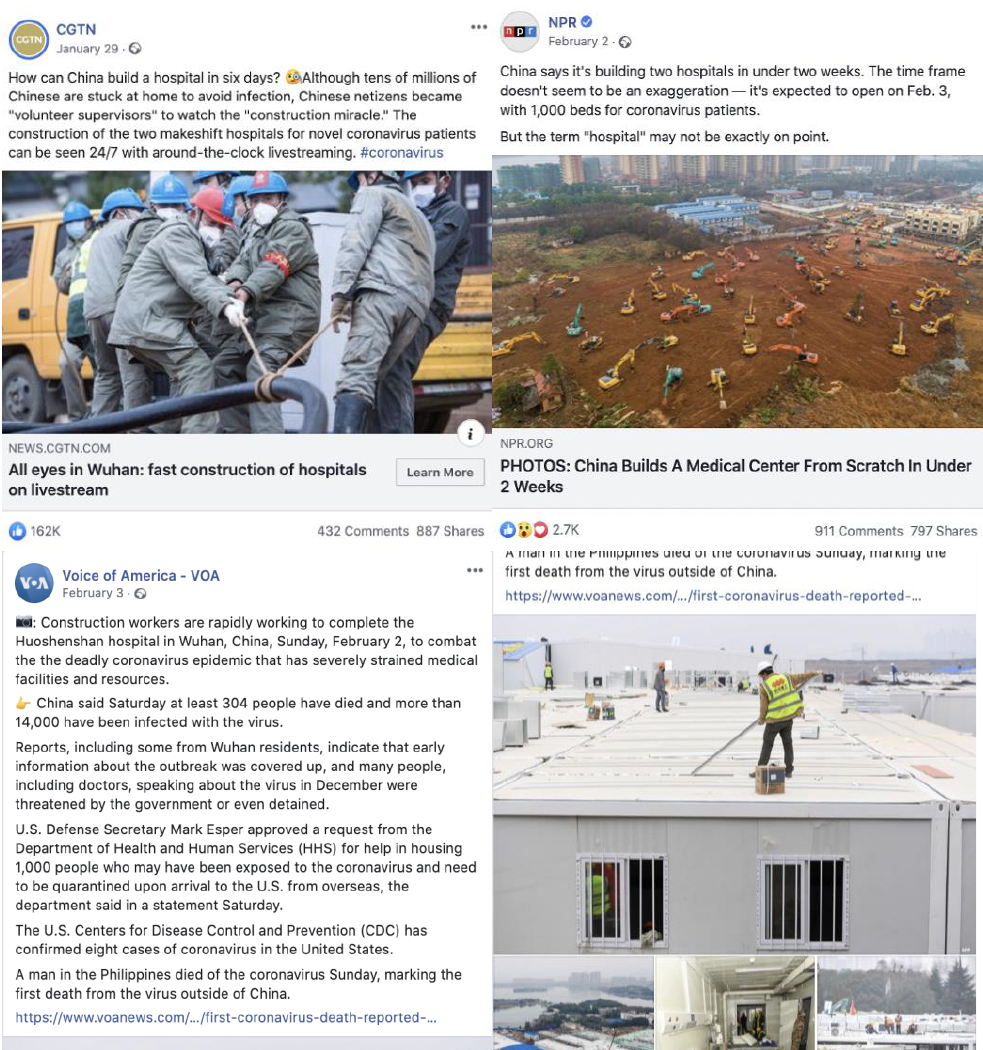
Figure 4 : Top: Chinese state outlet CGTN (left) calls the hospital a “construction miracle”; NPR (right) reports on the building, but qualifies that “the term hospital may not be exactly on point”; Bottom: U.S. government-funded outlet VOA shares images of the construction at Huoshenshan stating that the pandemic had “severely strained medical facilities